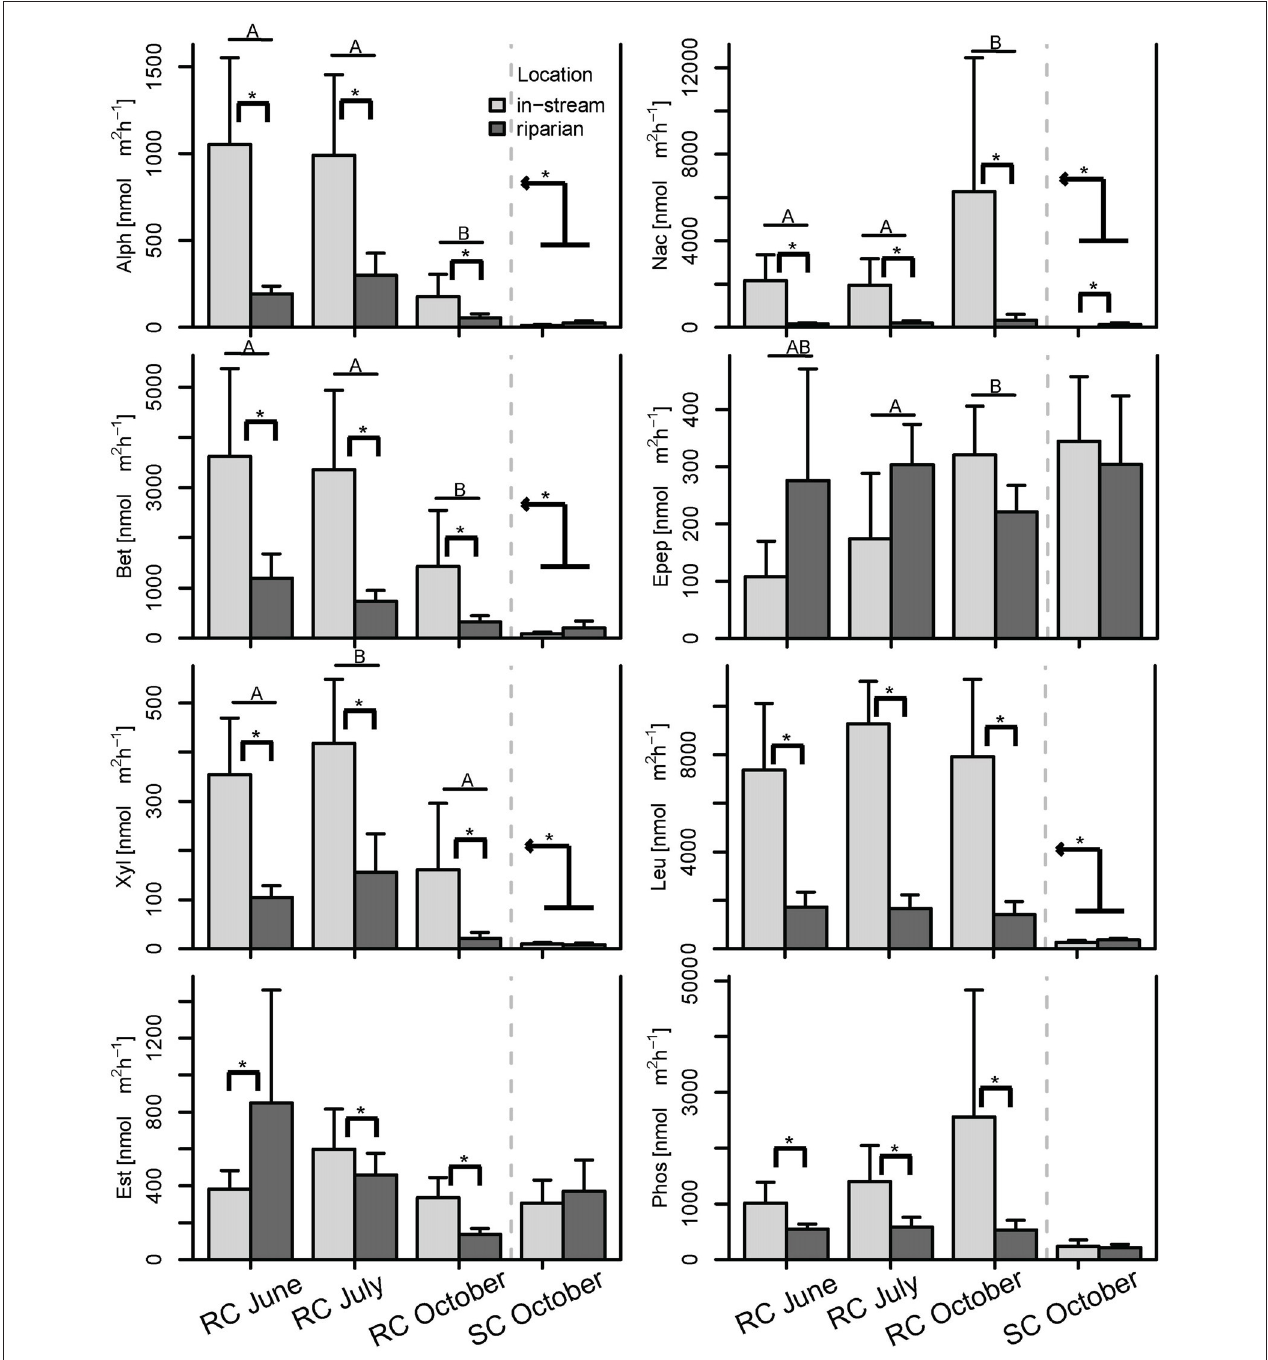
FIGURE 6 | Bar plot of the enzymatic activities split by season and location. Post-hoc test results are displayed as follows: Bars with different letters show significant differences between seasons, brackets with asterisks depict significant differences between concurrently sampled locations and the kinked arrow with asterisk shows overall differences between the two systems across all samples ( p < 0.05 ). Whiskers are standard errors.